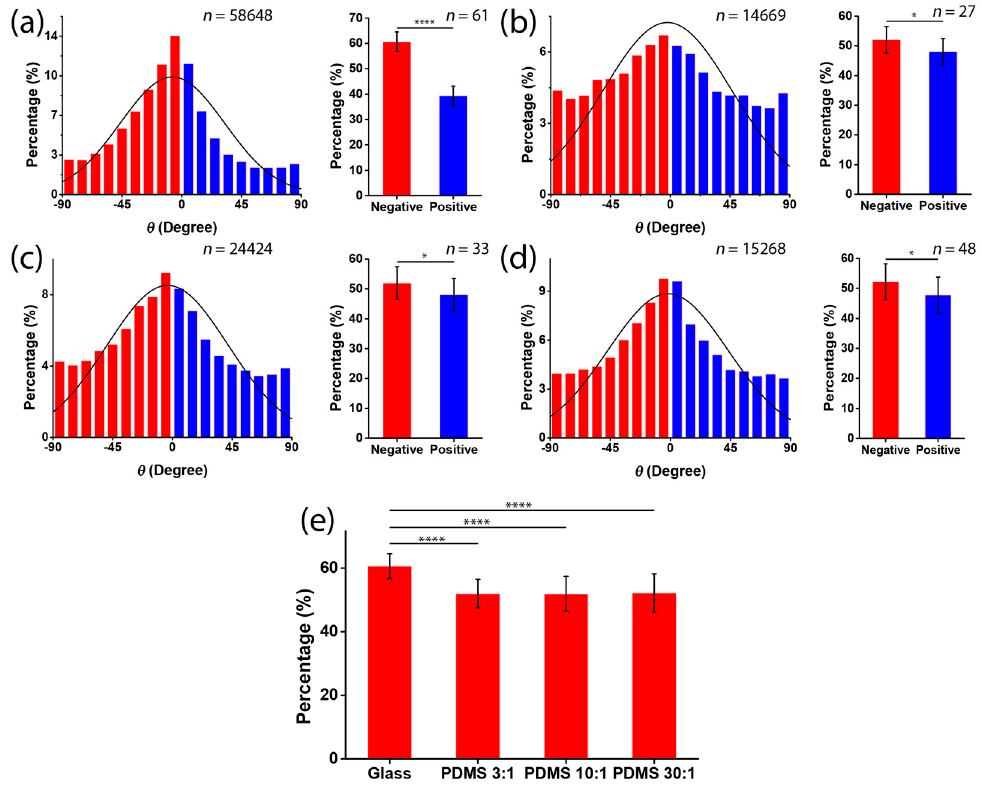
Figure 3. Chirality of cell orientation on substrates with different stiffness. ( a – d ) Histograms of cell orientation θ when cells were cultured in micropatterned stripes fabricated on glass substrates ( a ); PDMS substrate, ratio of elastomer to cross-linker = 3:1 ( b ); PDMS substrate, ratio of elastomer to cross-linker = 10:1 ( c ); and PDMS substrate, ratio of elastomer to cross-linker = 30:1 ( d ); ( e ) the percentages of negatively aligned cells on the four different substrates (mean ± SD).